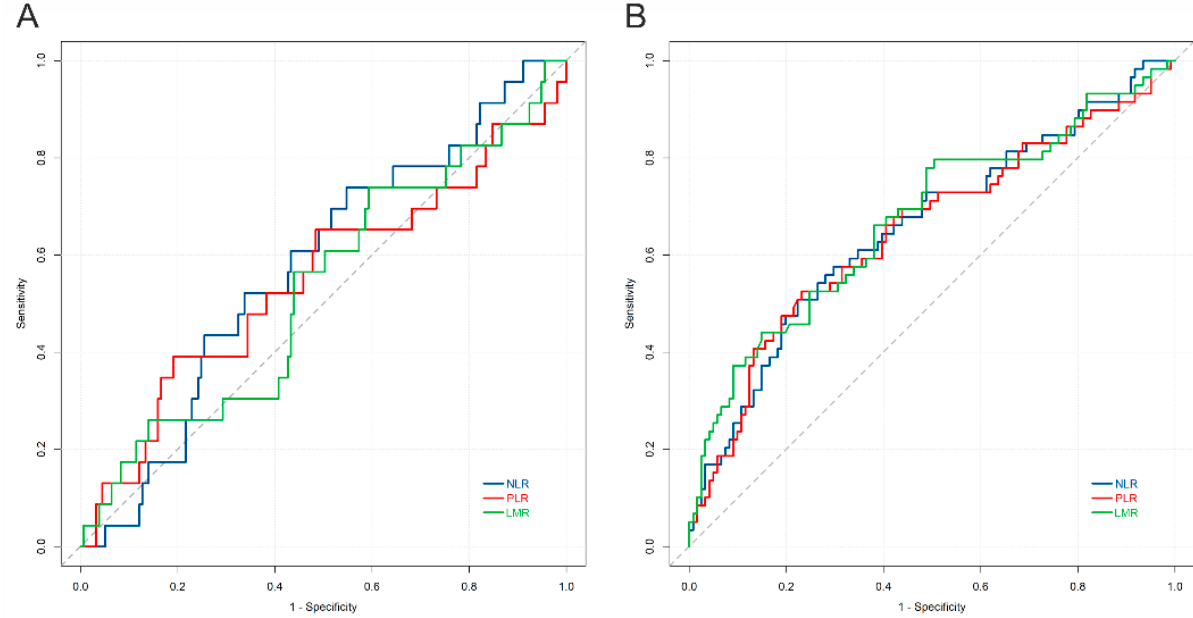
Figure 5. Receiver operating curves for NLR, LMR, PLR, versus ( A ) event (relapse, progression, or death), and ( B ) high stage. The AUC for the prediction of event was: NLR = 0.57; PLR = 0.54; LMR = 0.53; the AUC for the prediction of stage was: NLR = 0.65; PLR = 0.65; LMR = 0.67. Abbreviations: NLR: neutrophil-to-lymphocyte ratio; LMR: lymphocyte-to-monocyte ratio; PLR: platelet-to-lymphocyte ration.